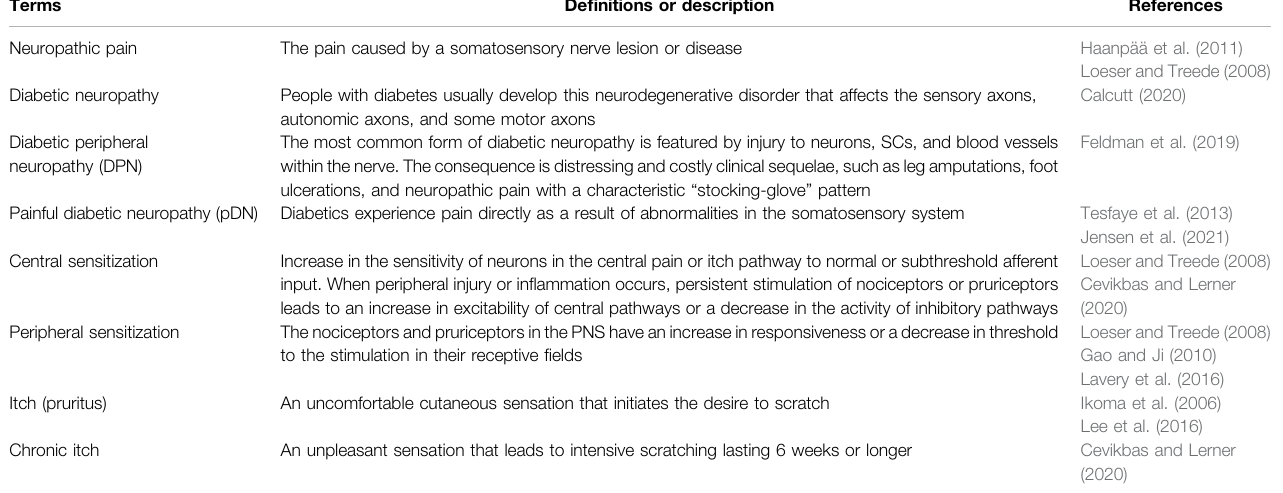
TABLE 1 | Terms and related de fi nitions or